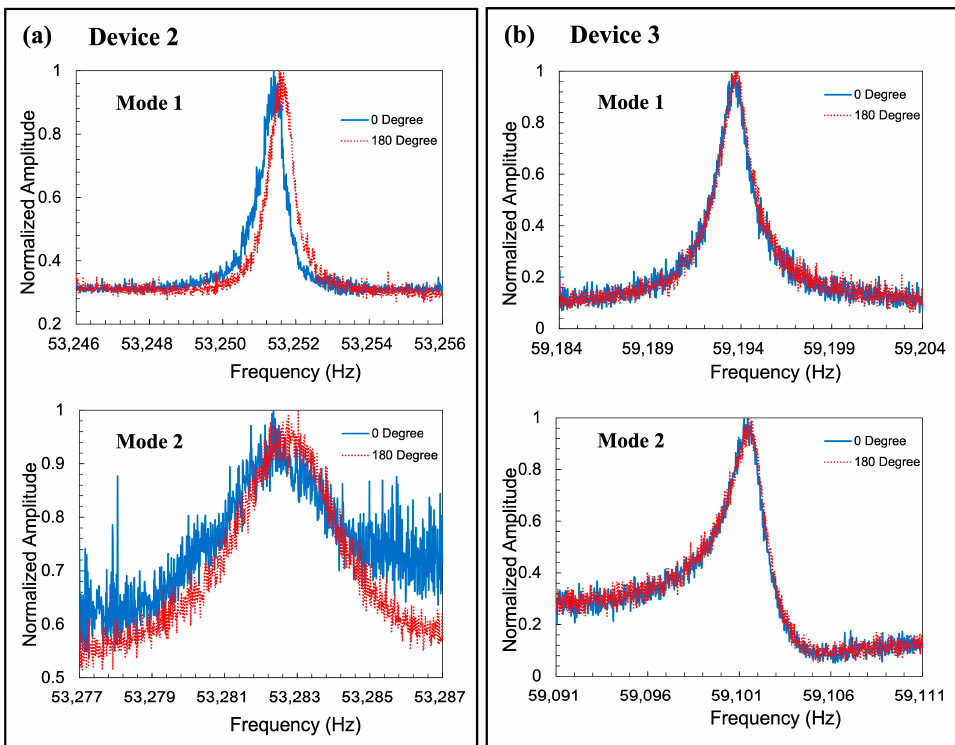
Figure 16. Detected amplitude change in Mode 1 and Mode 2 of ( a ) resonator 2 and ( b ) resonator 3 with elliptic spokes. All of the devices have the same design parameters. Table 2. Experimental results of fabricated conventional resonator and proposed resonator. Proposed Resonator Conventional Resonator (with Elliptic Spokes) (with Linear Beams)